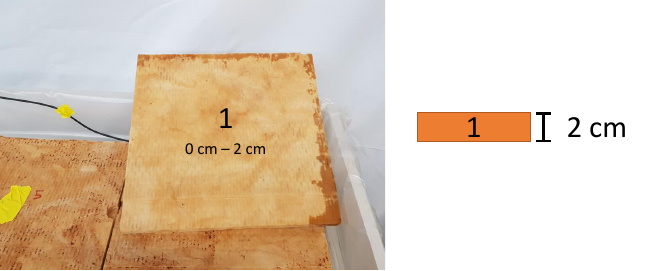
Figure 13. Water ingress (dark dyeing) in the 2 cm GW insulation. The picture shows the bottom of the used insulation plate (40 cm × 40 cm × 2 cm) in quadrant IV.